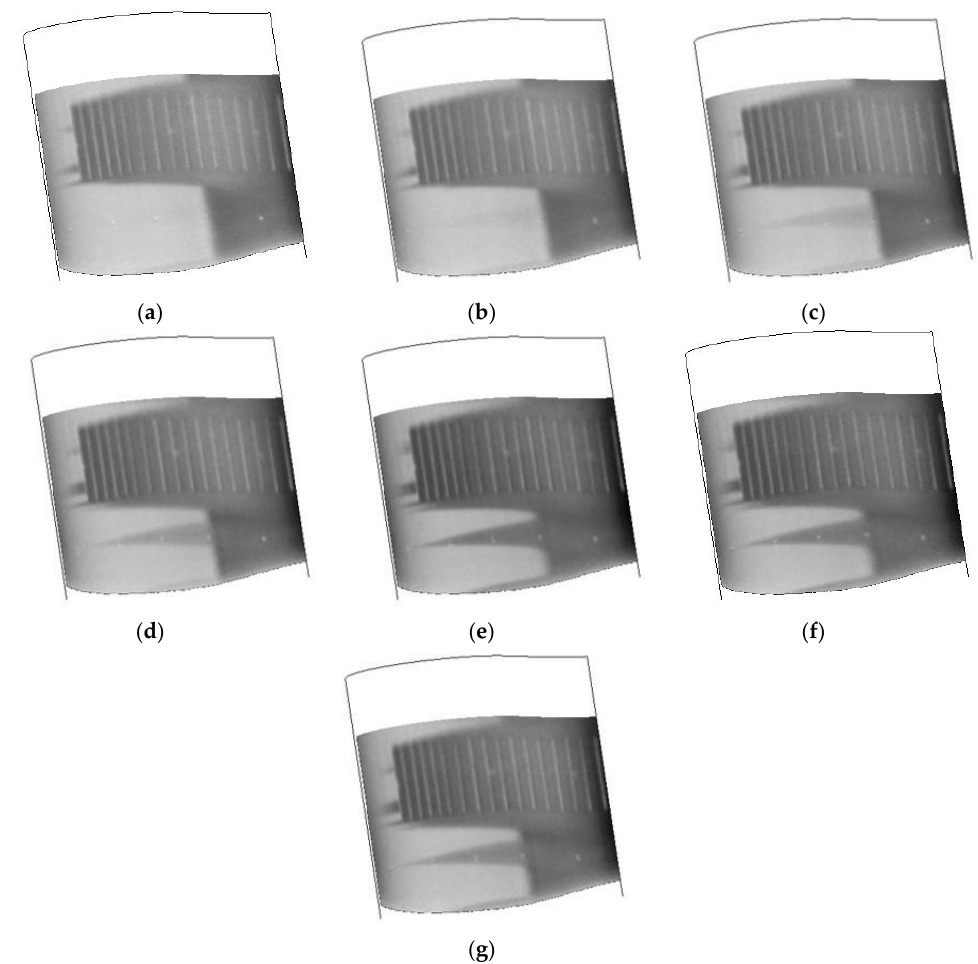
Figure 16. Temperature images collected after introduction of a temperature step using the fast injection method. Tunnel conditions are the same as Figure 13: ( a ) 10 s; ( b ) 10.4 s; ( c ) 10.8 s; ( d ) 11.2 s; ( e ) 11.6 s; ( f ) 12 s; and ( g ) 12.4 s.